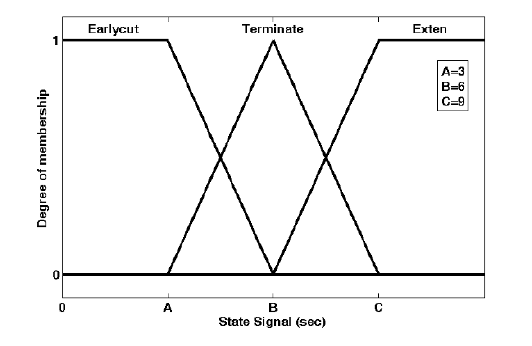
signal time controller. The membership functions of this parameter are represented with three sub-sets: "Few", "Many", and "Too many" (Fig.5).